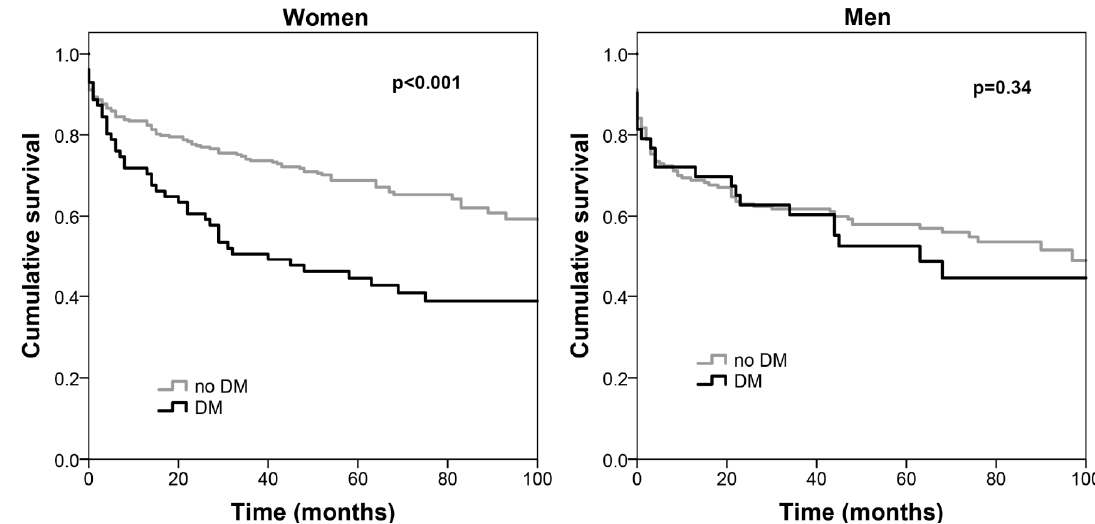
Figure 1. Kaplan–Meier survival curves of patients with acute PE according to the coexistence of DM. Diabetics have worse survival. PE: pulmonary embolism; DM: diabetes mellitus.